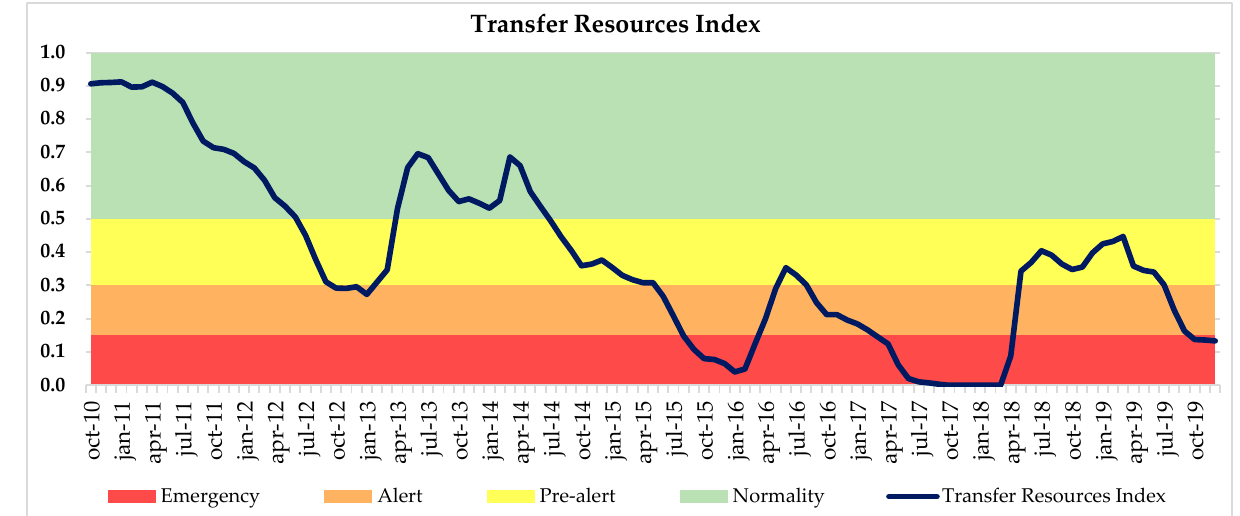
Figure 11. Evolution of the index of the transfer resources (temporary scarcity) in the Segura Basin, period October 2010–December 2019. Source: own elaboration based on [64].